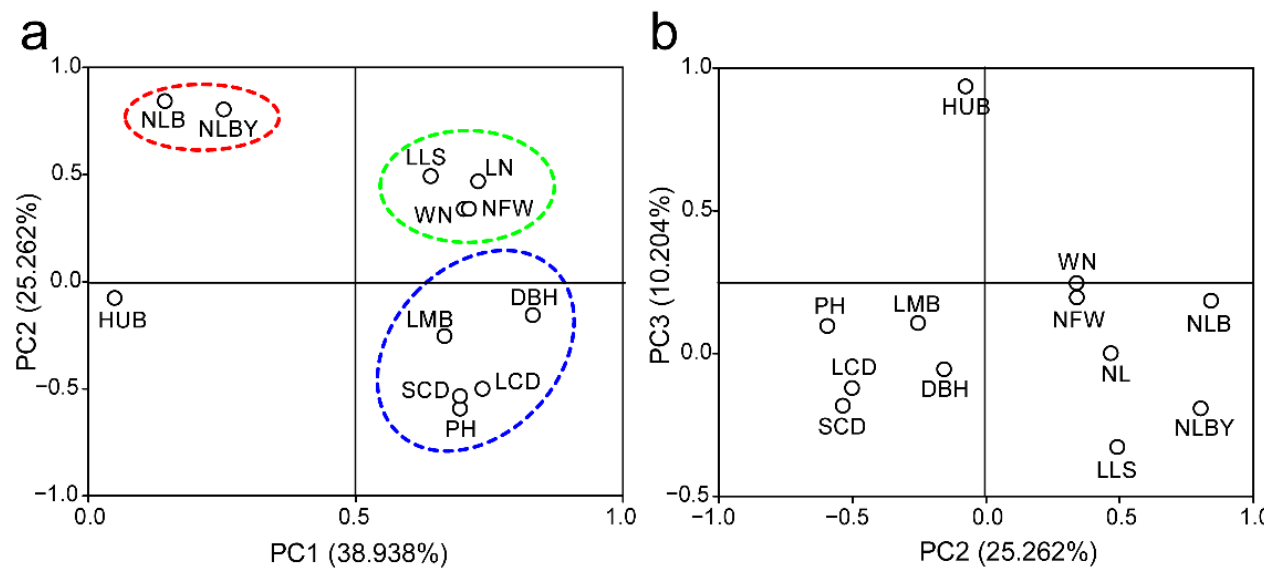
Figure 3. Principal component analysis of phenotypic traits of P. yunnanensis populations. Drawing a scatterplot with PC1 as the X -axis and PC2 as the Y -axis, three naturally segregating groups were formed ( a ). Draw a scatterplot with PC2 as the X -axis and PC3 as the Y -axis ( b ). Phenotypic trait abbreviations are shown in Figure 2.